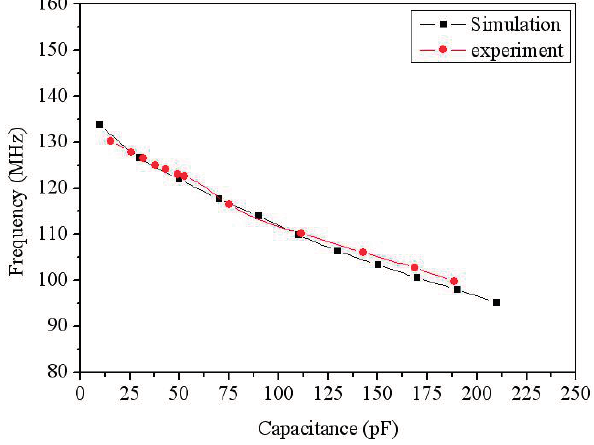
Figure 16. Relation between output frequency and capacitance for the acetone